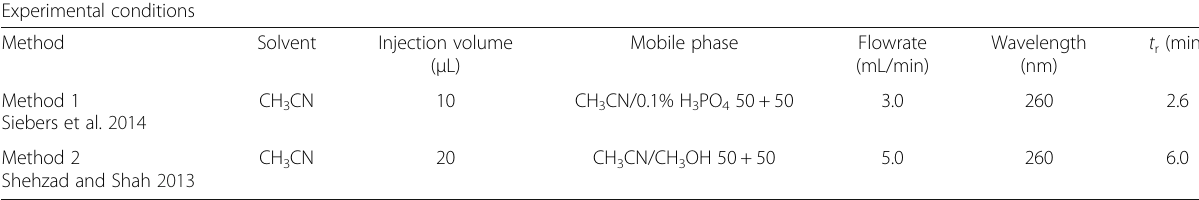
Table 5 Experimental conditions for HPLC analysis of PXD in soil and wheat grain samples Experimental conditions Method